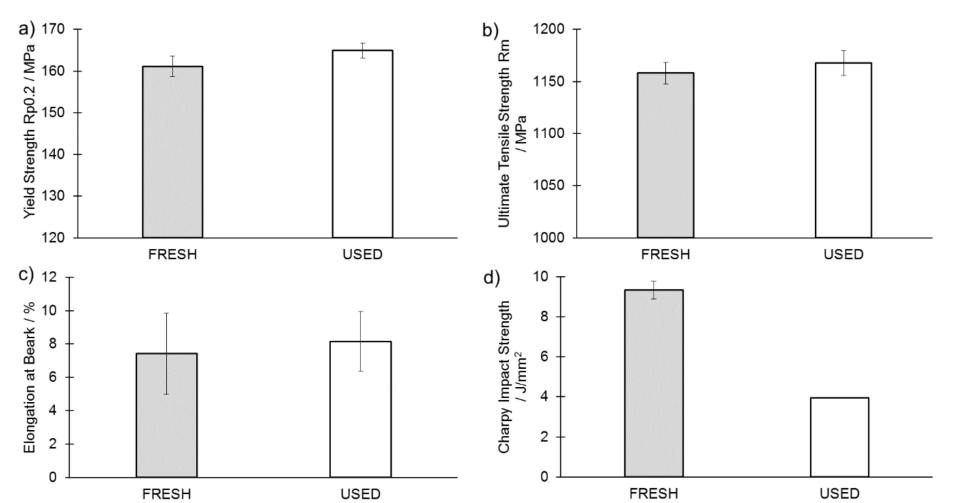
Figure 13. Comparison of properties of samples produced from FRESH and USED Ti6Al4V powders: